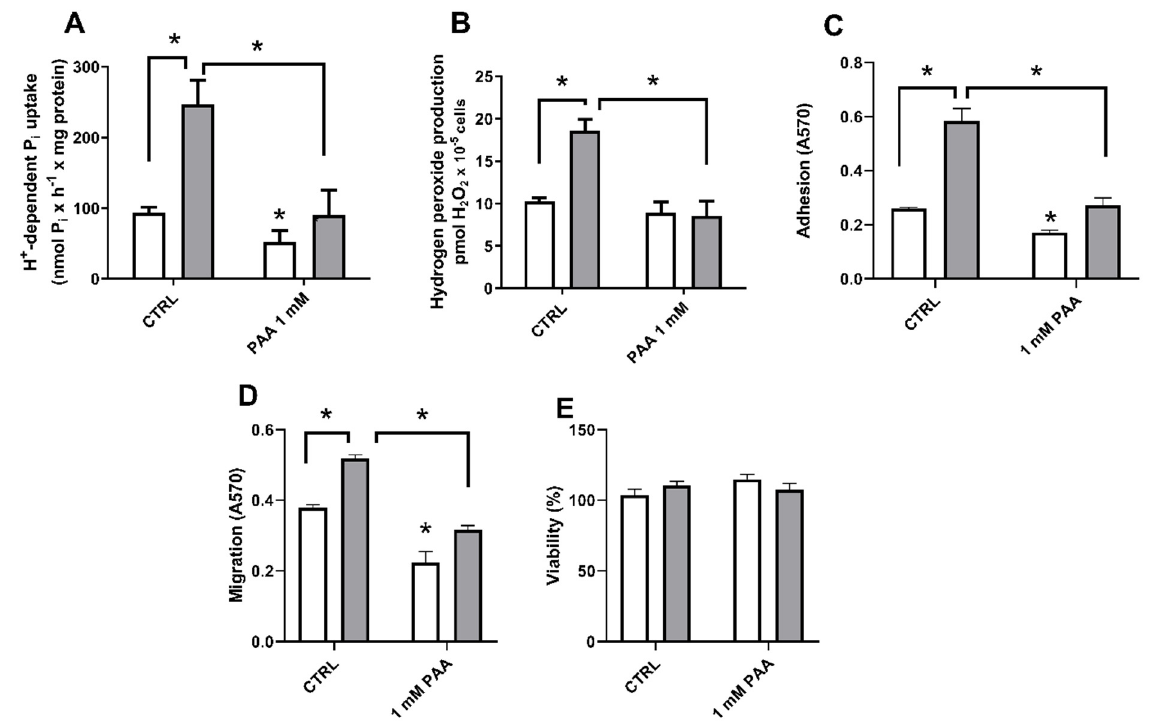
Figure 5. PAA effect on high Pi-induced Pi transport, migration and cell adhesion to ECM in MDA-MB-231 cells. MDA- MB-231 cells were treated with 1 mM Pi (blank bars) or 8 mM Pi (grey bars) for 24 h in the absence (control) or presence of an H + -dependent Pi transport inhibitor, PAA (1 mM). H + -dependent Pi uptake ( A ), H 2 O 2 production ( B ), cell adhesion to ECM ( C ), cell migration ( D ), and cell viability ( E ) were performed as demonstrated in Section 4. Bars represent mean ± SE of at least 3 independent biological samples. * p < 0.05 indicates changes significantly different, as assessed by ANOVA followed by Tukey’s multiple comparison test.